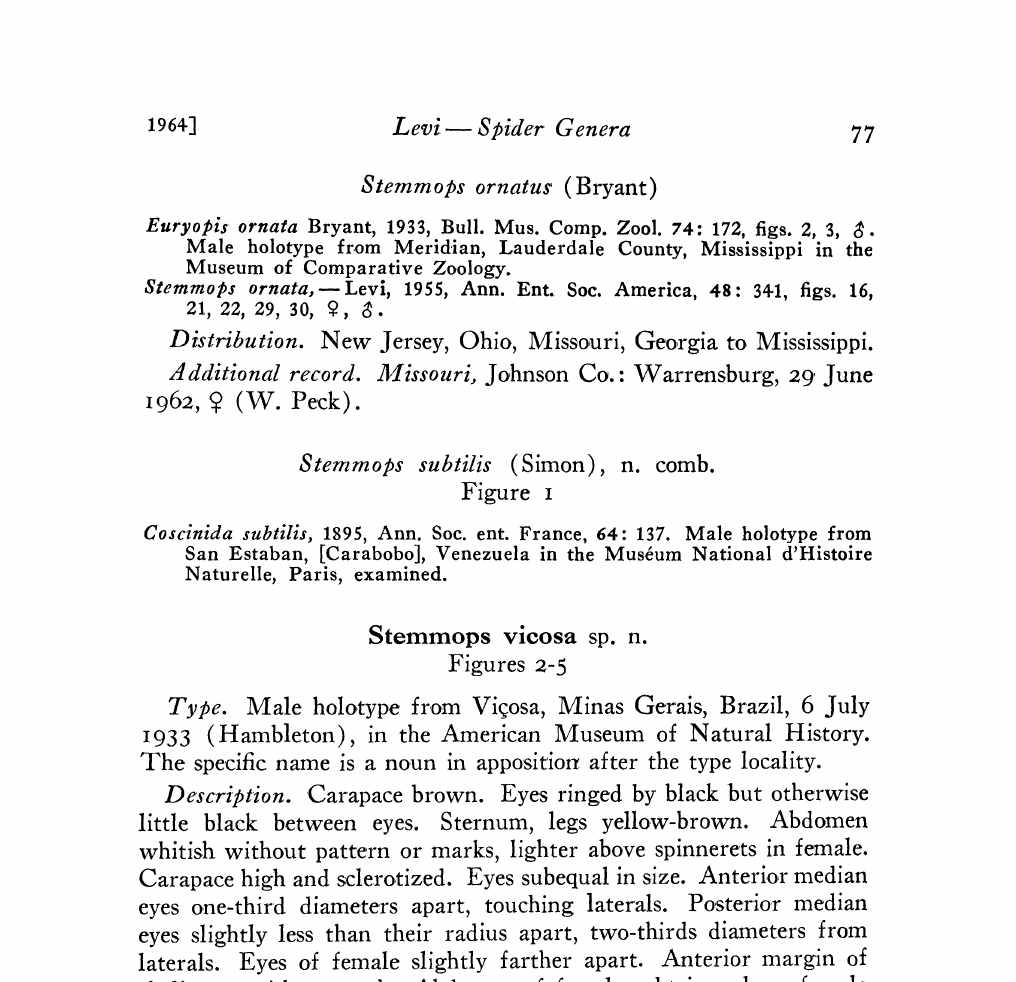
Fig. 1. Ste,nmops subtilis (Simon), left palpus. Figs. 2-5. 8. ,icosa sp. n. 2. Male. 3. Palpus. 4. Female genitalia, dorsal view. 5. Epigynum. Figs. 6-8. S. questa Levi. 6. Palpus. 7-8. Male. Figs. 9-12. S. serous sp. n. 9. Palpus. 10. Male. 11. Female genitalia, dorsal view. 12. Epigynum. Figs. 13-15. 8. mellus sp. n. 13. Female. 14. Female genitalia, view. 15. Epigynum. Figs. 16-18. $. orsus sp. n. 16. Female. 17. Female genitalia, view. 18.